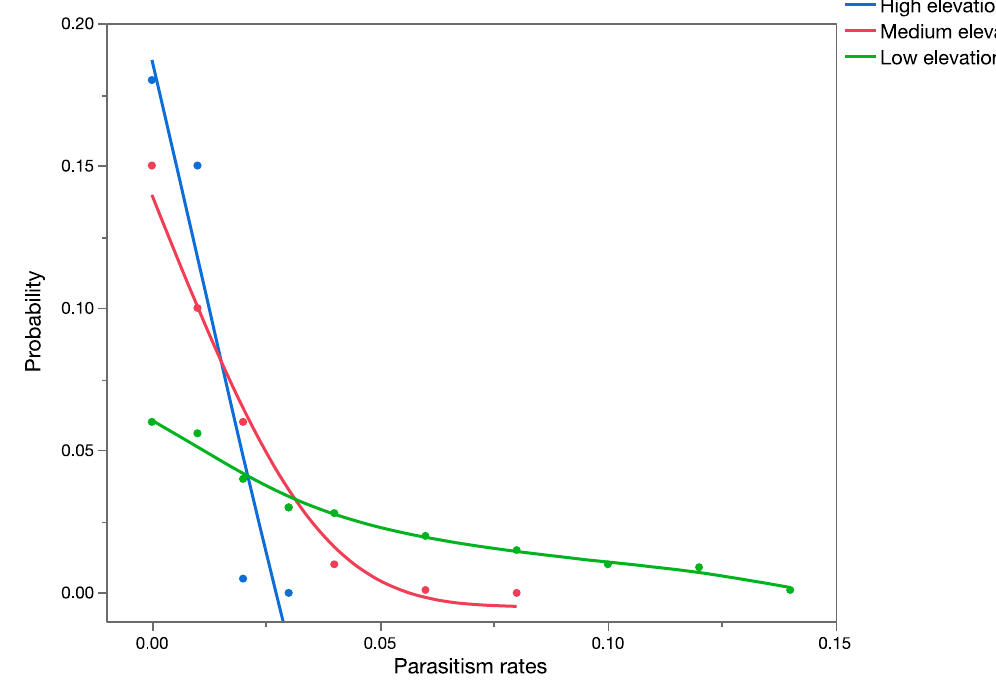
Figure 5. Overlay chart showing a forecast of all possible parasitism rates (as a proportion on the x -axis) for M. laphygmae at low-, medium-, and high-elevation sites using published data.